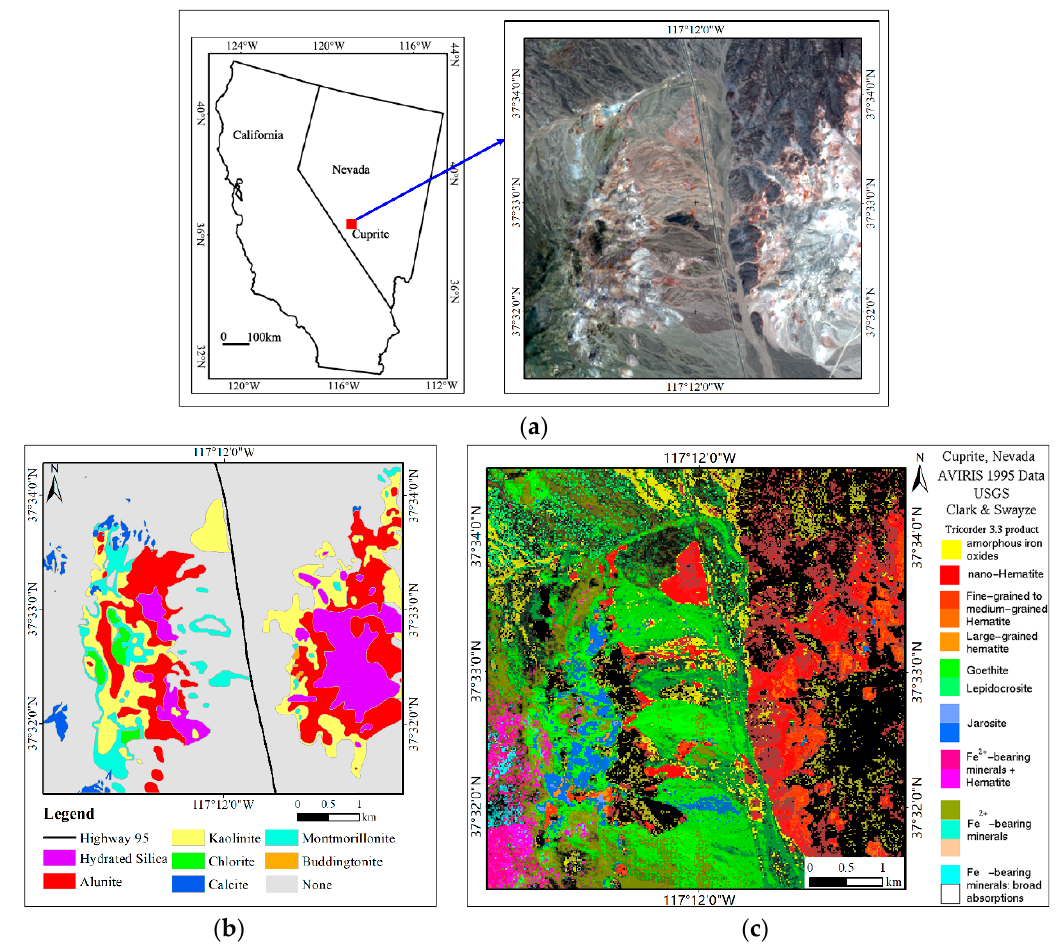
Figure 3. Location map ( a ), hydrothermal alteration minerals map ( b ) and iron-bearing minerals map ( c ) of the Cuprite area, modified after Mars et al. and Swayze et al. [43,48] (Map projection: WGS_1984_UTM_zone_11N).